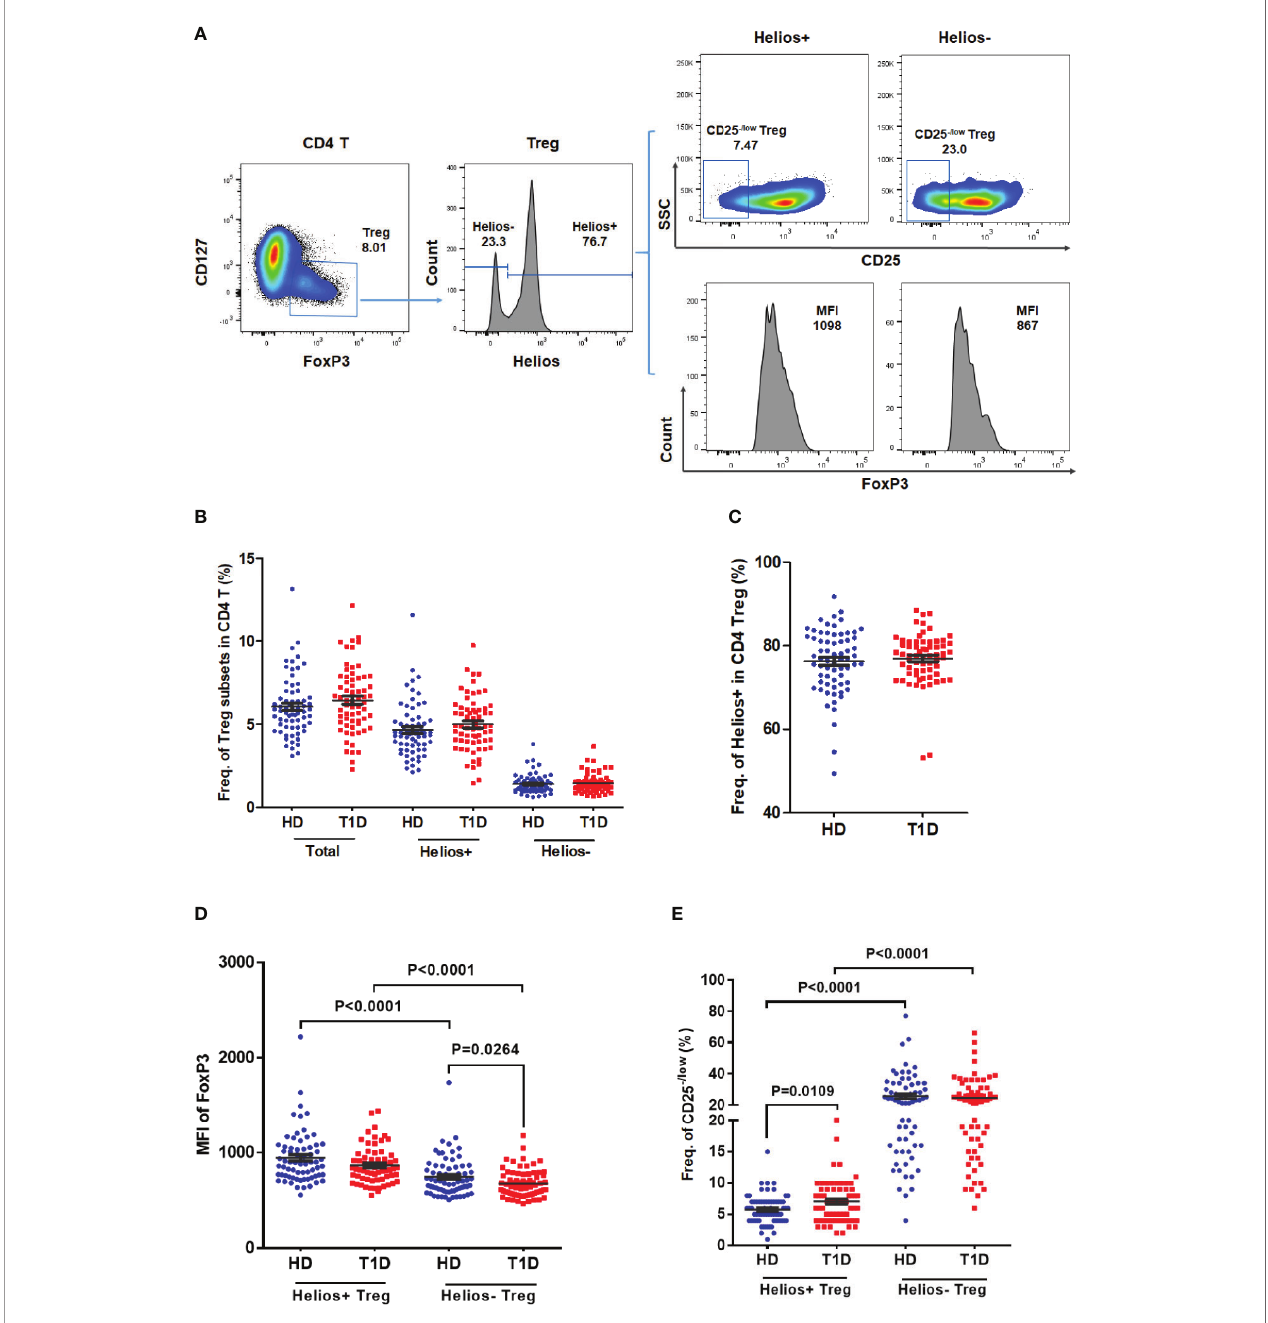
FIGURE 1 | The frequencies of Helios + and Helios − Treg subsets and their expression of FoxP3 and proportions of CD25 − /low Tregs in T1D individuals, compared to healthy controls. (A) A representative dot plot for gating CD25 and FoxP3 expression in Helios + and Helios − Treg subsets of a healthy donor. (B) Evaluation of the percentage of total, Helios + and Helios − Tregs in CD4 T cells between T1D and healthy controls. (C) Evaluation of the percentage of Helios + and Helios − Tregs in total Tregs between T1D and healthy controls. (D) Differences in mean fl uorescence intensity (MFI) of FoxP3 in Helios + and Helios − Tregs of T1D and healthy controls. MFI of FoxP3 was measured to compare the level of expression of this molecule. (E) Differences in frequency of CD25 − /low in Helios + and Helios − Tregs of T1D and healthy controls. HD, healthy controls. Wilcoxon test was used for statistical comparison between the two different subsets. The results were from 68 autoantibody-positive T1D individuals and 68 age-matched autoantibody-negative healthy controls. Samples from T1D individuals and healthy controls were randomly divided to each independent experiment. One biological sample (from the same healthy donor and drawn at the same time) was performed as control for the experimental reproducibility. Comparisons between T1D and healthy controls were performed by unpaired t test with Welch ’ s correction. A p value below 0.05 indicates a signi fi cant difference between